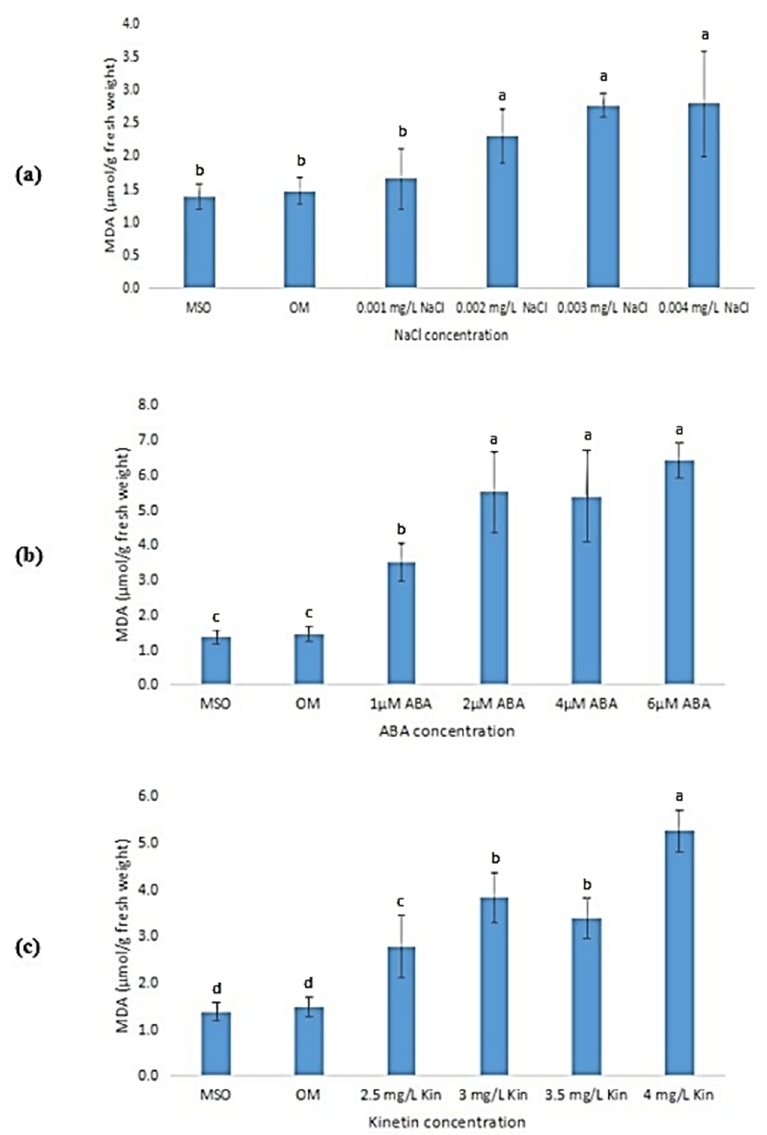
Figure 9. MDA levels of plants exposed to: ( a ) salt stress; ( b ) ABA; ( c ) high kinetin levels. Means with different letters are significantly different at p < 0.05 according to Duncan’s multiple range test (DMRT).